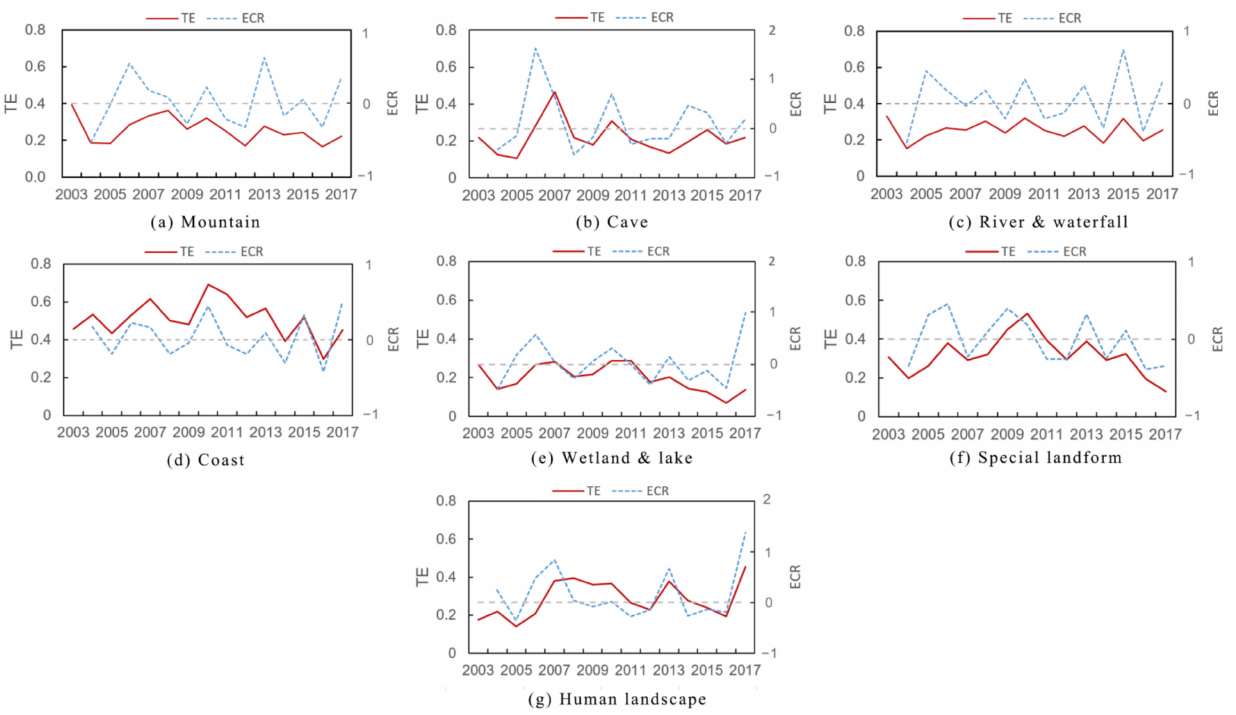
Figure 5. Line charts of tourism efficiency values for different types of NSA from 2003 to